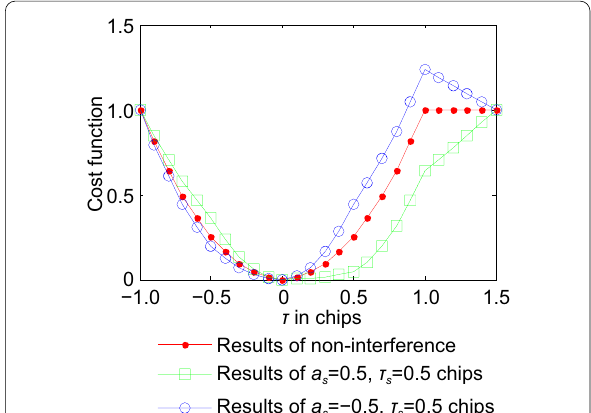
Fig. 2 Cost function curve under different interference forms. The red curve shows the cost function without interference. The green curve demonstrates the cost function distorted by an in-phase NLOS signal. The blue curve exhibits the cost function distorted by an out-of-phase NLOS signal